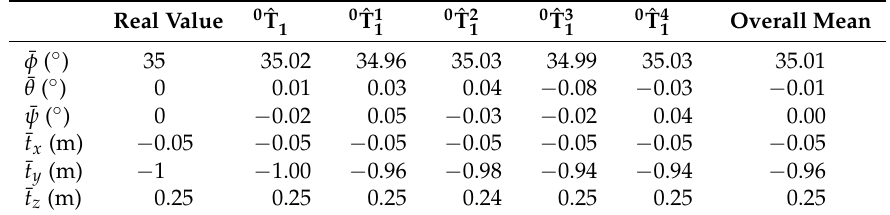
Table 2. Mean values of the six variables for the transformation paths using a Gaussian distribution of errors on all variables with an initial uncertainty of 5.7 ◦ for angles and 0.1m for translations.